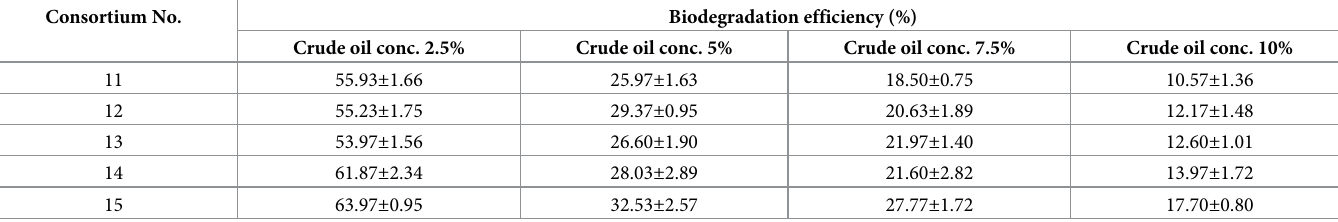
Table 9. Effect of crude oil concentration on biodegradation efficiency of crude oil of 5 fungal consortia. Consortium